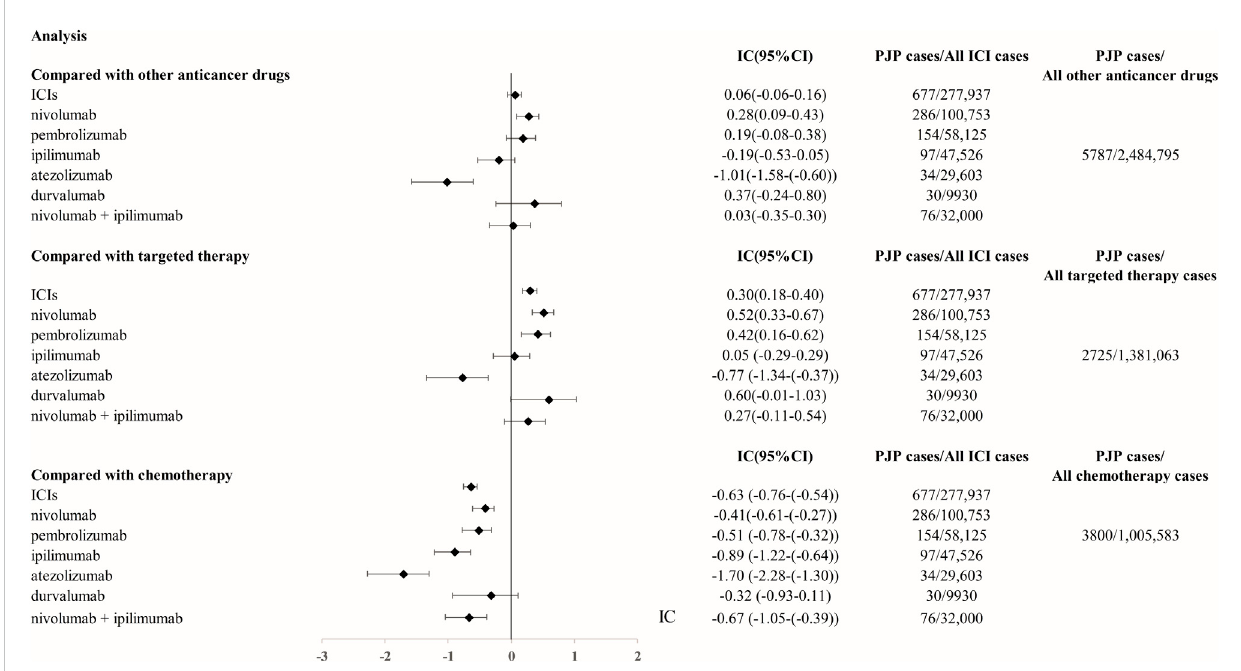
FIGURE 2 The comparison of Pneumocystis jirovecii pneumonia signal between ICIs and targeted therapy/chemotherapy in FAERS database. The list of control group (targeted therapy and chemotherapy) was extracted from NCCN guidelines for FDA approved indication of ICIs. Abbreviation: PJP, Pneumocystis jirovecii pneumonia. ROR, reporting odds ratio. IC, information component. 95%CI, 95% con fi dence interval. N, number. AEs, adverse events. ICIs, immune checkpoint inhibitors. NCCN, National Comprehensive Cancer Network.